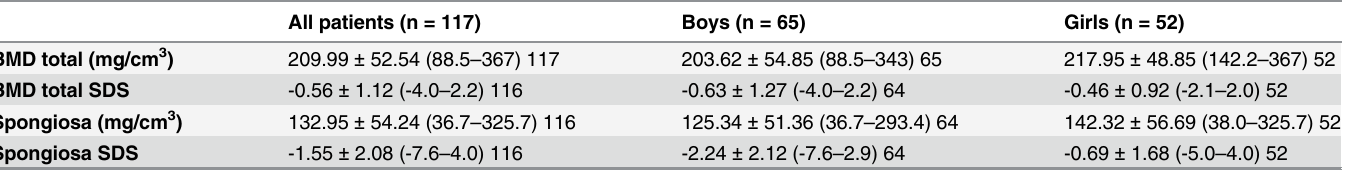
Table 3. Results of the pQCT readings.